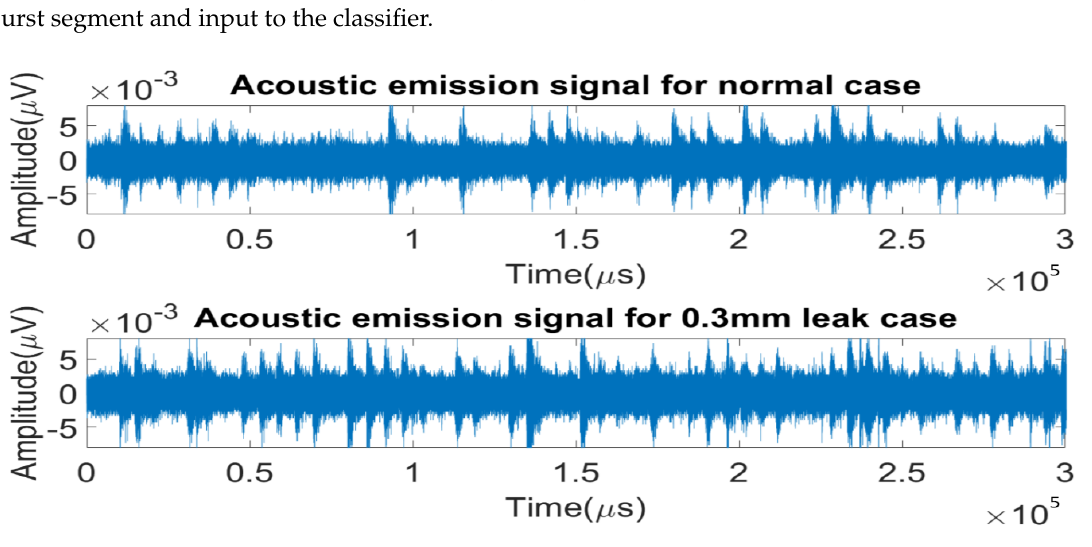
Figure 3. An example of four-class classification scenario and true decision boundaries using the one- versus-all multi-class support vector machine